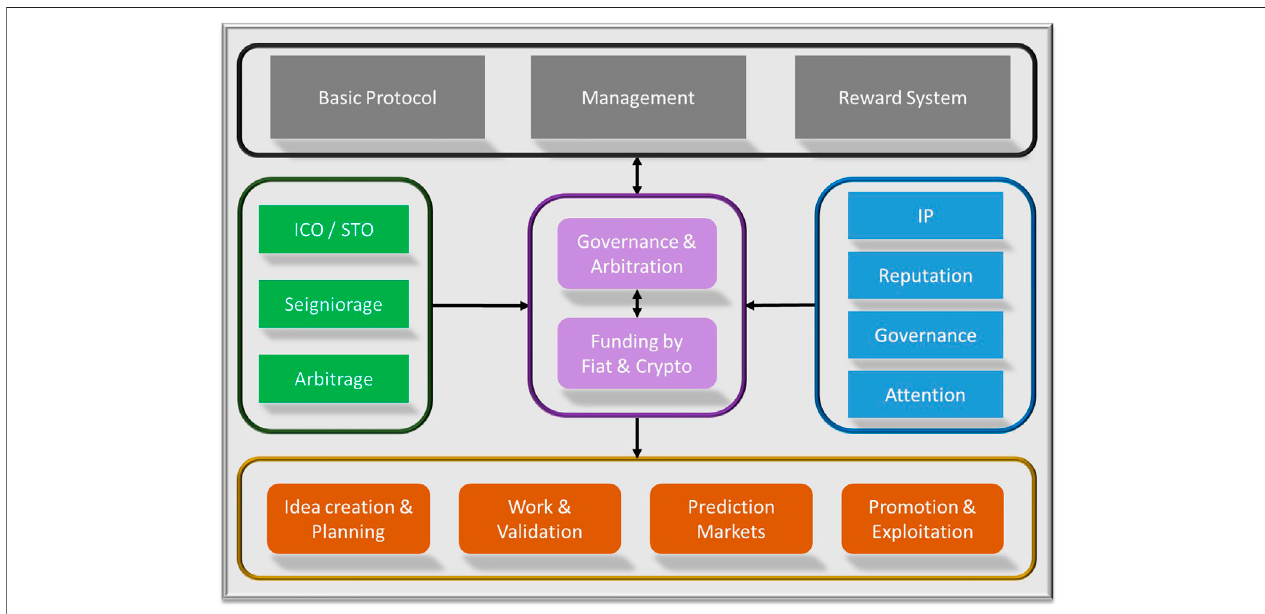
FIGURE 2 | Organization of science and RTD by a token-based crypto-economy. A white paper documents a basic protocol, management structures, and reward systems whichareencodedandexecutedonablockchain.Governanceandarbitrationfollowingliquiddemocracyschemesareattheheartofdecision fl exibleupdatingofrulesets,directing, andcon fl ictresolution.BlockchainmechanismssuchasICOs/ITOs/STOs,seigniorageandarbitragegenerateconventional, fi at-convertiblefunding.Acohortofcryptotokenscanbe awarded to users in the crowd, for example, for contributions such as ideas, planning, work, validation, forecasting, exploitation, and even to externals by learning about or referencingtheproject,andthusraiseattention.Therecipientsmightdeploytheserewardstoincreasevotingrightsintheliquiddemocracygovernance,topolishuptheircurriculumvitae (CV), to claim ownership in intellectual property (IP), and, in a potential secondary market, trade them into other crypto